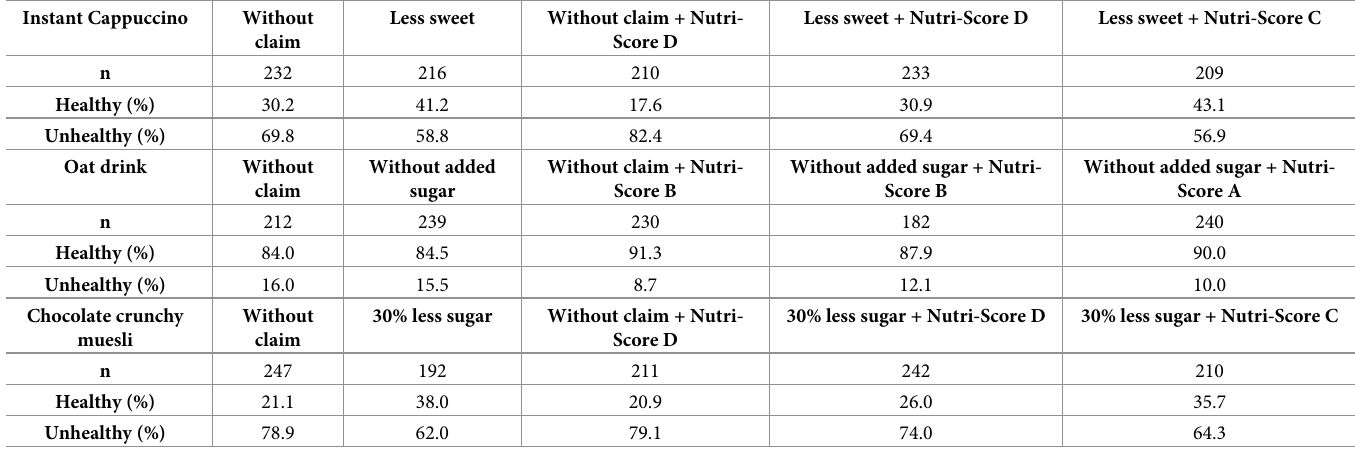
Table 3. Frequencies of the health evaluation of three products with/without claim and Nutri-Score. Instant Cappuccino Without claim